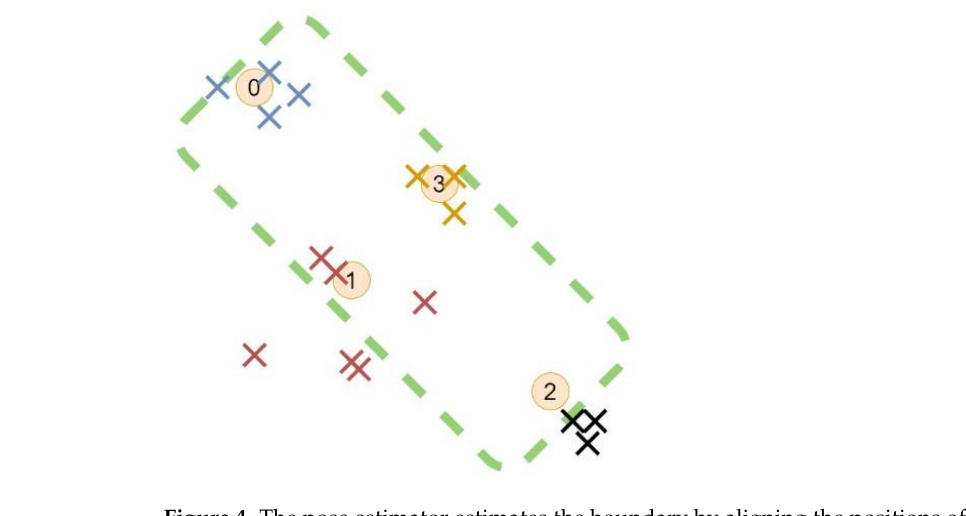
Figure 4. The pose estimator estimates the boundary by aligning the positions of the mounted tags on the vehicle (circles) with the calculated locations (cross). Table 2. Parameter table for pose estimation optimizer.